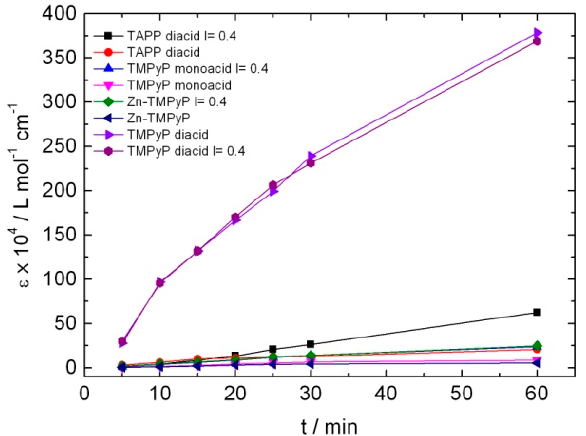
Figure 5. Kinetics of triiodide formation: extinction coefficient ε at λ = 353 nm versus irradiation time for porphyrin-linear PSS in acidic aqueous iodide solution. Table 5. Generated concentrations of triiodide (mol/L) after 5 h of irradiation. Porphyrin species